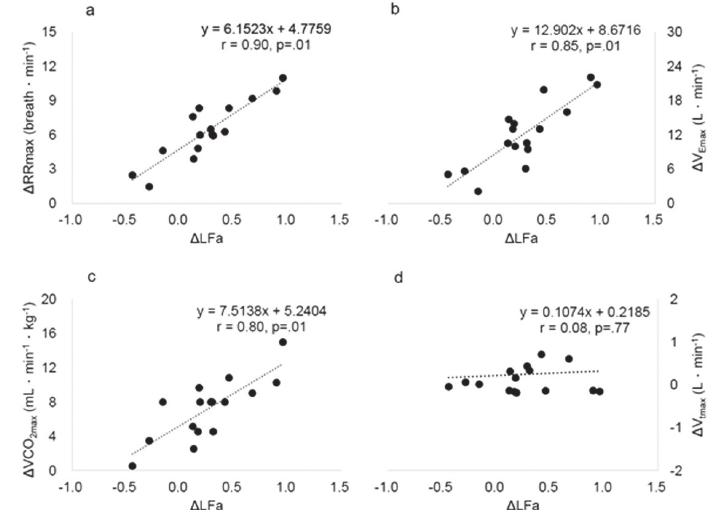
Figure 1. Correlation analysis of pulmonary parameters and HRV by Pearson correlation in MPU. MPU: Mentha piperita essential oil uptake group. ΔRRmax: difference values of respiratory rate between baseline and maximal exercise. ΔV : difference Emax values of ventilation in minute between baseline and maximal exercise. ΔCO : difference values of carbon dioxide production 2max between baseline and maximal exercise. ΔV : difference values of tidal volume between baseline and maximal exercise. ΔLFa: tmax difference values of low-frequency area (sympathetic activity) between pre-intervention and